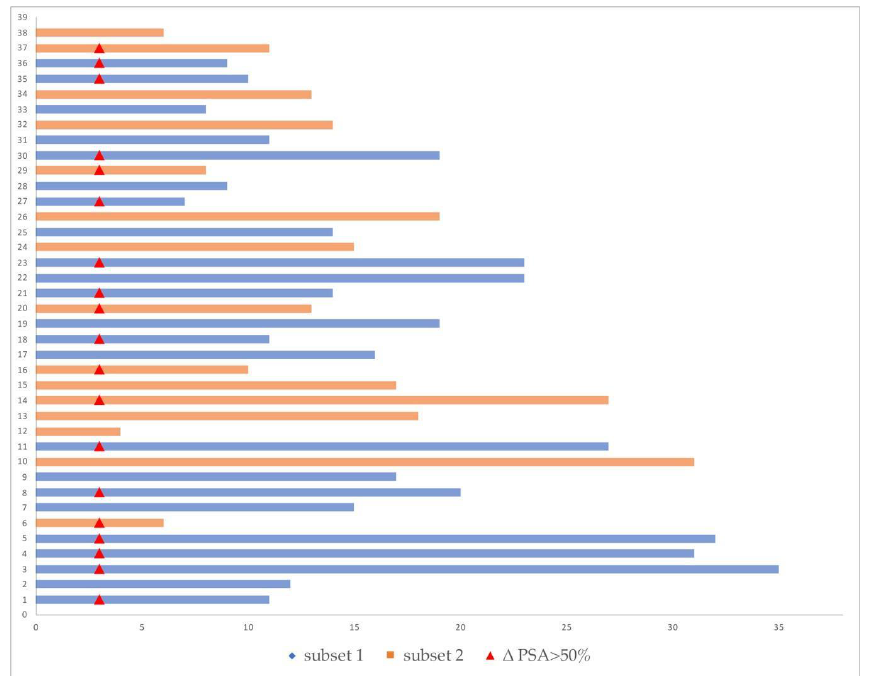
Figure 2. Swimmers plot with time to new biochemical recurrence (BCR) in Subset 1 (blue line) and Subset 2 (orange line) after r-RT. The red points represent patients with a PSA reduction of more than 50% three months after